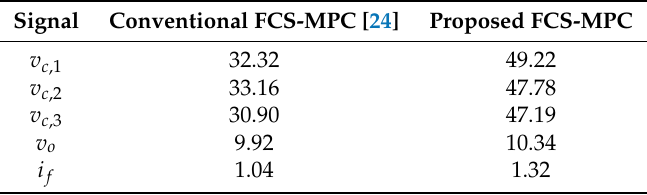
Table 4. Key waveforms THD% until harmonic 51